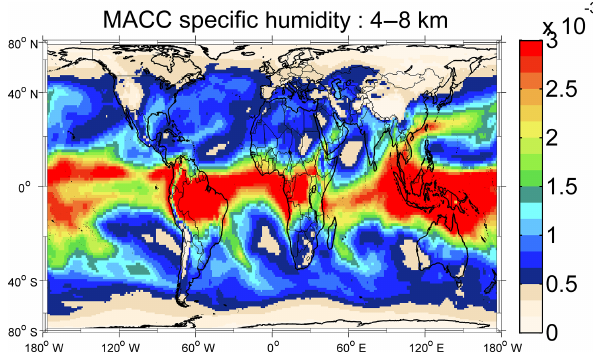
Figure 12. Specific humidity (kgkg − 1 ) at 4–8km in April 2006 from MACC reanalysis data set.